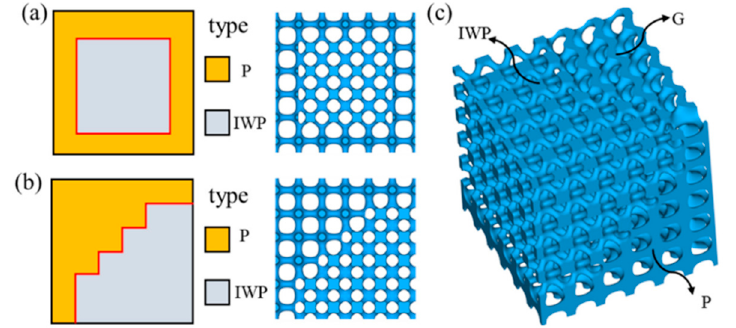
Figure 6. Two examples of hybridizing cellular materials, shown here for two kinds of TPMS geometries (Schwarz Primitive P, and Schoen IWP), with ( a ) an embedded transition boundary; ( b ) curve discretization; and ( c ) representation in 3D; reproduced from [22] under CC BY-NC-ND.